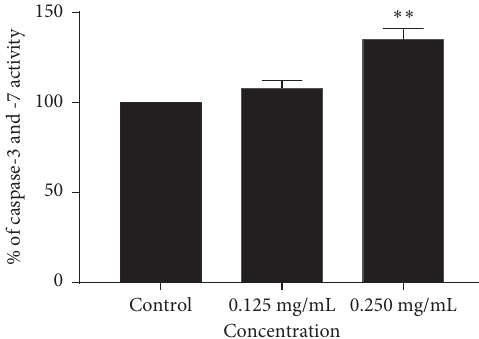
Figure 5: Caspase-3/7 activation in HA-GA-NP-treated bCSCs at 48h after incubation ( p < 0 . 0082).